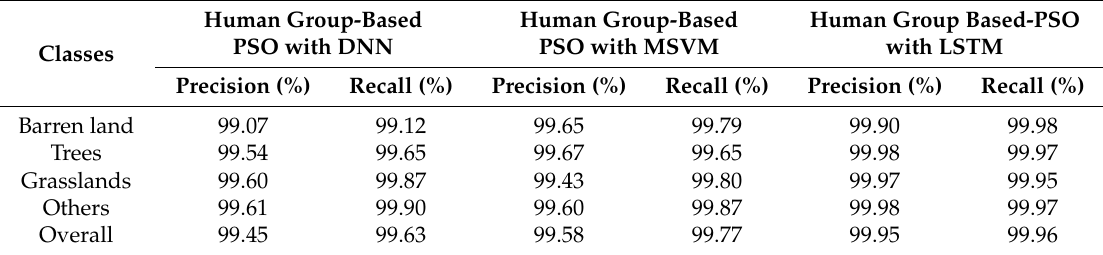
Table 4. Performance investigation of the proposed model with di ff erent classifiers on Sat 4 dataset by means of recall and